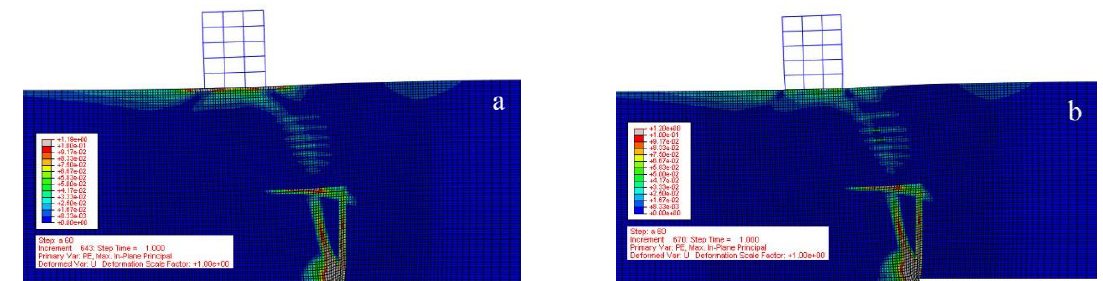
Fig. 13. Fault route in two soil layers with DS-LS density for a 5 floor building: (a) raft foundation and (b) single